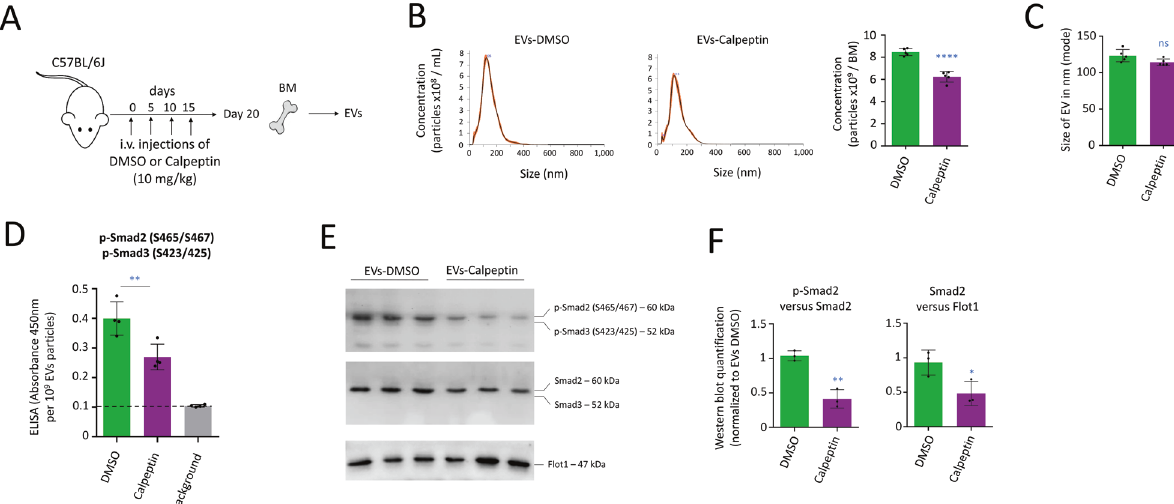
Fig. 1 Treatment of mice with the EV inhibitor Calpeptin affects the in vivo production of EVs carrying p-Smad2. A Procedure followed to treat C57BL/6J mice with Calpeptin in order to analyze EVs in BM. B NTA quanti fi cation of EVs isolated from mice BM at day 20. Data showing that Calpeptin reduced the number of EVs in BM by ~26%, n = 5 mice per group. C Size of EVs measured by NTA. D ELISA quanti fi cation of EVs showing a reduction in the detection of p-Smad2/3. Quanti fi cation was normalized to 10 9 particles, n = 4 mice per group. E Western blot with 50 µg of proteins extracted from EVs, n = 3 mice per group. Data showing the presence of p-Smad2 and Smad2, but not p-Smad3 and Smad3. Flotillin 1 (Flot1) generally detected on EVs was used as an endogenous control. F Quanti fi cation of the Western blots. On this fi gure, data are shown as means ± SD. P value measured by two-tailed unpaired Student ’ s t test; * P < 0.05; ** P < 0.01; **** P < 0.0001; ns, non-signi fi